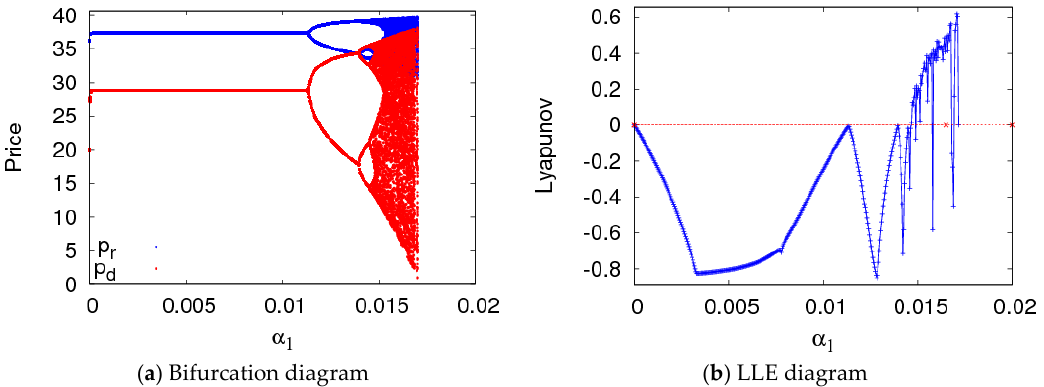
Figure 5. The features of dynamic System (7) with the change of 𝛼 1 when 𝛼 2 = 0.008.